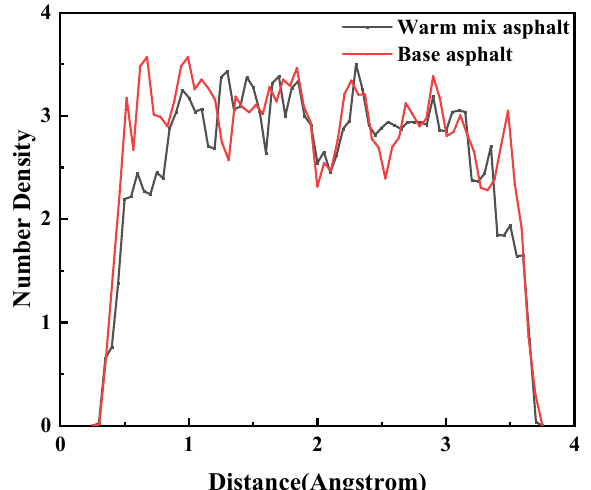
Figure 12. Number density profile of asphalt component molecules in the warm mix asphalt lubricating film along the z-axis.